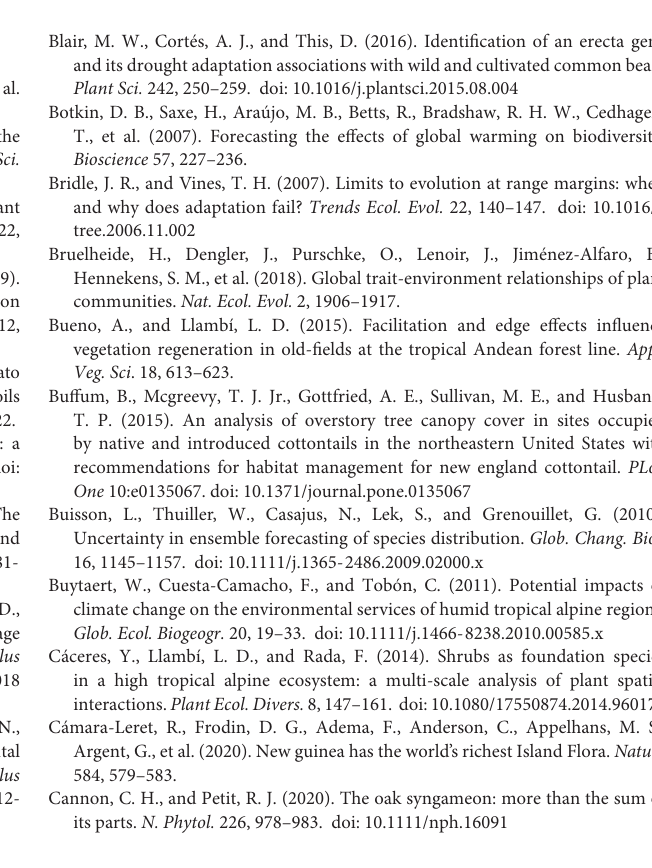
subset, test gains, test AUC, AUC standard deviation, pseudo-absences (number of background points), and entropy. The following relative contribution scores are kept for the six environmental variables: contribution, permutation importance, training gain, test gain and AUC without and with only each variable. The six Coldest Quarter, and (DEM) Digital Elevation Model. Supplementary Table 6 | Current model validation based on Akaike (AIC) and Bayesian (BIC) Information Criteria per repetition of each of the 28 Espeletia taxa. Optimum training and testing subsets are summed under N TR + TS . Supplementary Table 7 | Climate sensitivity (S), adaptive capacity (AC), and climate vulnerability (V) in the Espeletia complex across Páramo sky islands in the Colombian Andes. The adaptive capacity enhancing components were diversity (D), protected areas (PA) and forest area around the Páramo (F), while its limiting factors were agriculture (A), mining (M) and rural population density (RPD). Diversity (D), which is the number of Espeletia taxa totalized in a 1 km grid based on the occurrence data downloaded from GBIF, and the inverse value of the normalized rural population density (RPD) were scaled from 0 to 1. A total of 1,050 protected areas (PA) were rated as 1, 0.3, 0.1, and 0.1 for National Natural Parks, Civil Society Reserves, Regional Natural Parks and National Protected Forest Reserves, respectively, following (CIAT, 2017). Forest patches (F) around the Páramo complexes (2 km around the tree line, 1 km grid) were recorded as presence points (1 = presence), while agriculture (A) and mining (M) for the period 2010–2012 were marked as null data points (0 = presence) within the study area and in its buffer zone (2 km around the tree line, 1 km grid). The area of each of the 36 Páramo complexes is also presented in hectares (Ha), as well as its name and ID number following Figure 2A , Morales et al. (2007) and Londoño et al.